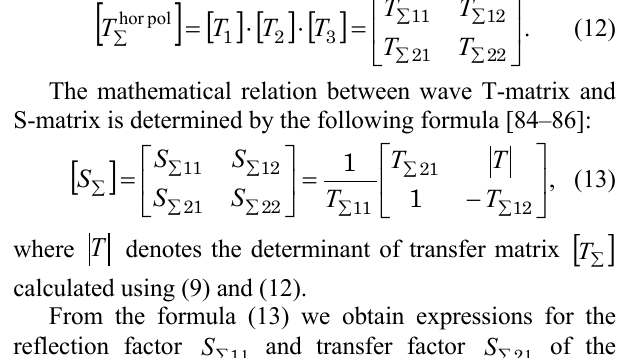
FIGURE 4. Dependences of module of transmission coefficients on frequency for both linear polarizations calculated by the mathematical